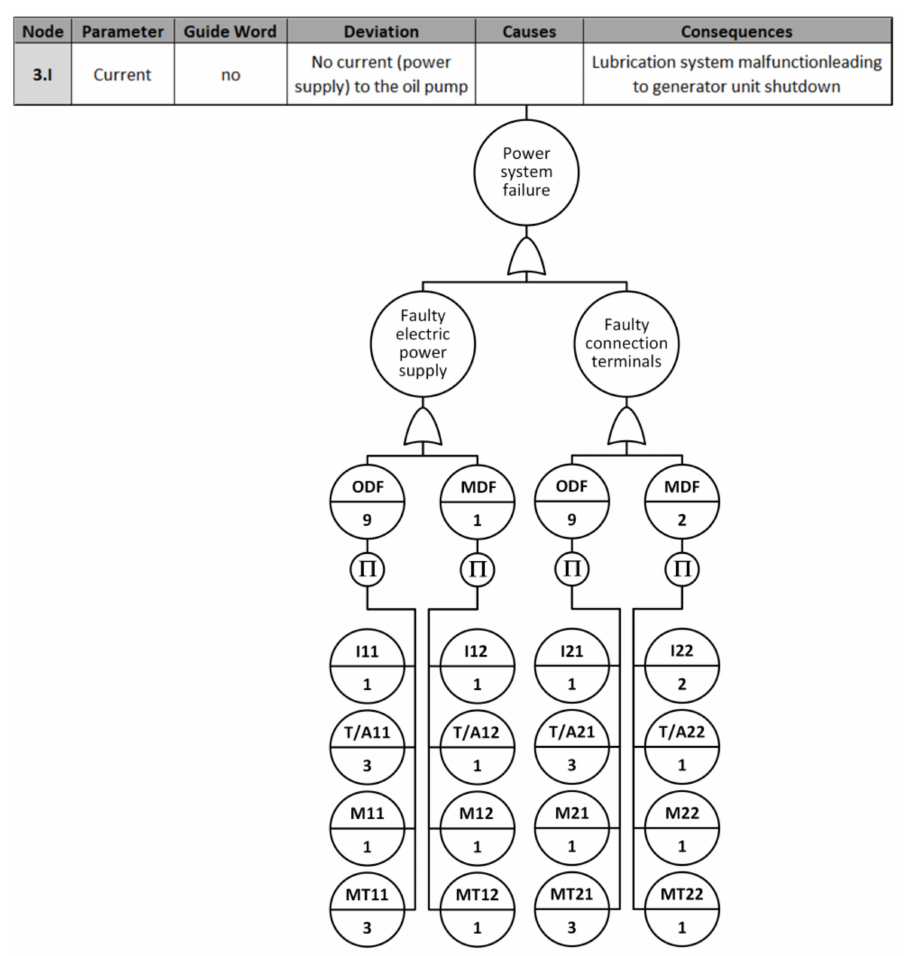
Figure 5. Operation & Maintenance Tree Analysis (OMCTA) example diagram considering node 3.I previously presented in the HAZOP